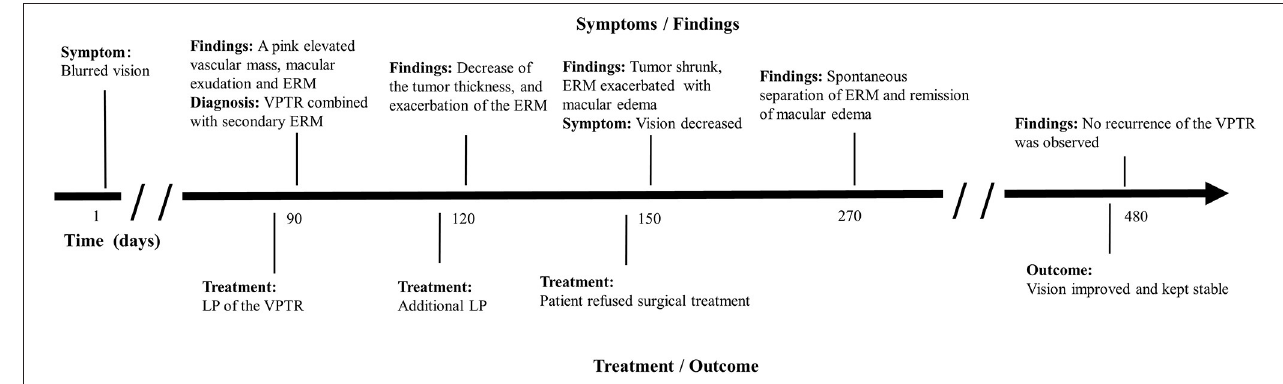
FIGURE 1 | Clinical timeline for a 56-year-old Chinese male patient with a VPTR. VPTR, vasoproliferative tumor of the retina; ERM, epiretinal membrane; LP, laser